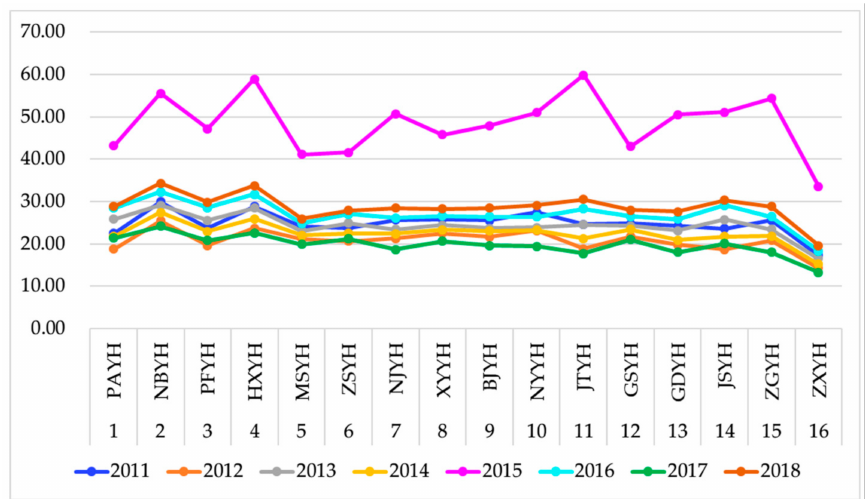
Figure 13. Measurements of dynamic ∆ CoVaRs (The left axis refers to the value of ∆ CoVaR (the di ff erence between the Conditional Value at Risk (CoVaRs) when the bank is in distress and in a normal state) of each bank, based on the dynamic model which considers extreme circumstance and use a 1% quantile) (2011–2018, extreme